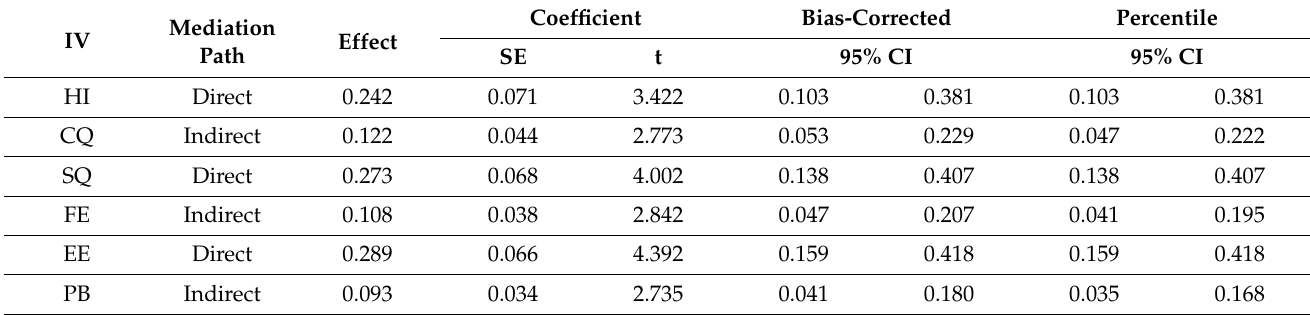
Table 5. The mediating roles of functional experiences in the relationships between system character- istics and